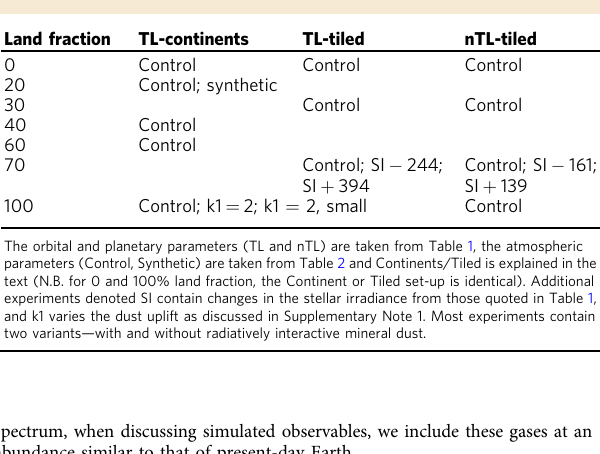
Table 3 Full list of the 28 experiments presented in this